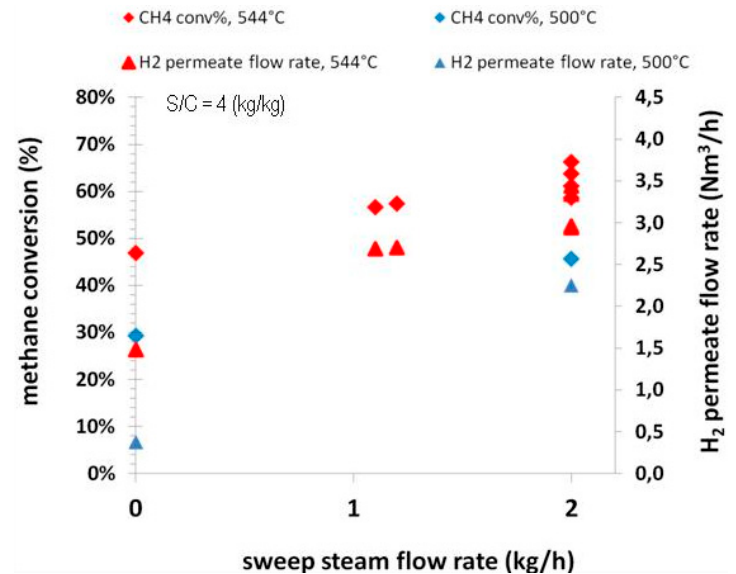
Figure 7. Effects of sweep gas flow rate on the methane conversion and the permeate H 2 flow rate.